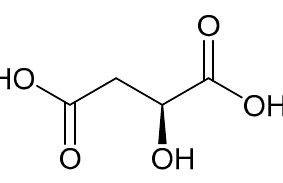
Figure 13. Structure of malic acid.